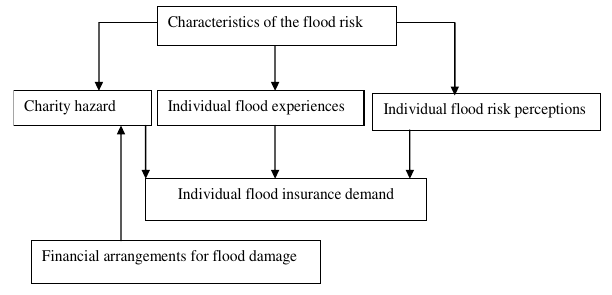
Fig. 1. Theoretical framework of factors of influence on individual flood insurance demand that are examined in this study